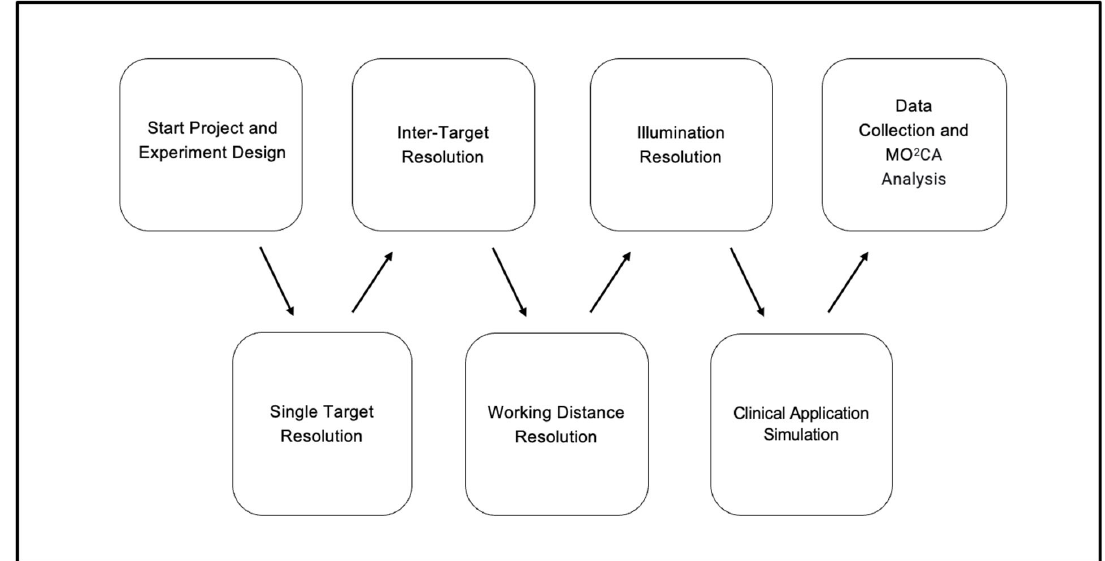
Figure 1. Flowchart depicting experimental protocols.